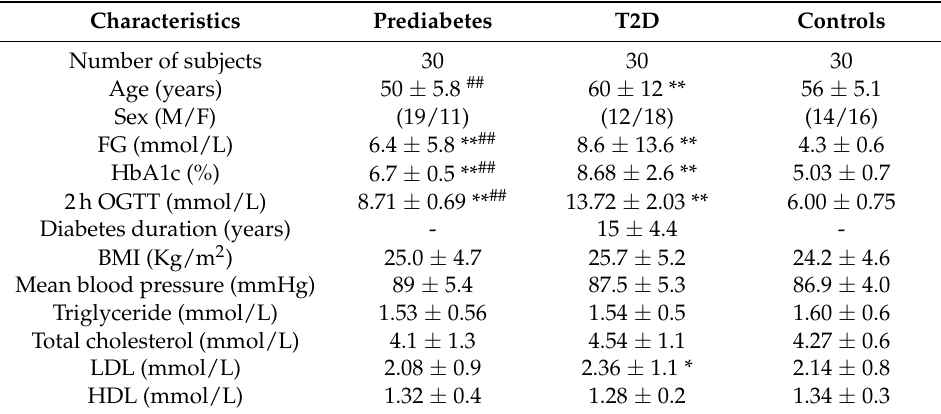
Table 2. Basic characteristics of the study